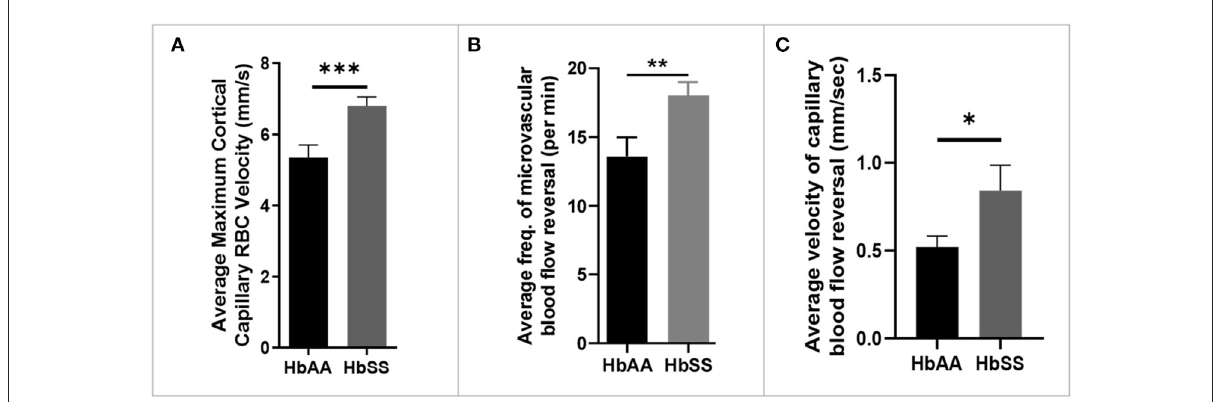
FIGURE2 Altered capillary hemodynamics in 13-month-old sickle cell mice compared to age-matched controls. (A) average maximum capillary RBC velocity in millimeters per second. (B) average frequency of capillary blood flow reversal per minute (C) average velocity of capillary blood flow reversal in millimeters per second (AA: n = 5, average of ∼ 194 vessel segments; SS: n = 7, average of ∼ 390 vessel segments). Error bars are standard error of means (SEM). * p ≤ 0.05; ** p ≤ 0.01; *** p ≤ 0.001. Mean comparisons done using Welch’s corrected t -test. Results here are only from the mice in the baseline